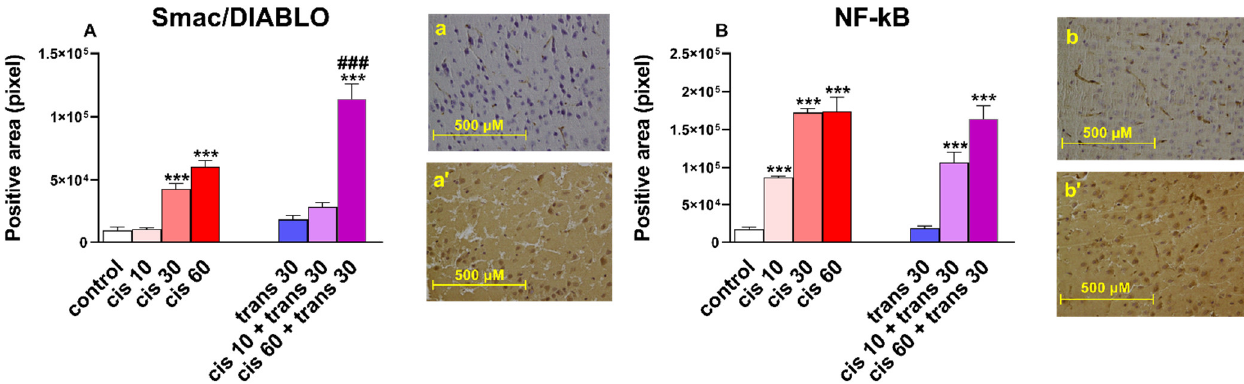
Figure 4. ( A ) Quantification and comparison of Smac/DIABLO positive areas in controls versus 4-4′-DMAR-mice ((±) cis 10, (±) cis 30, (±) cis 60, (±) trans 30, (±) trans 30 + (±) cis 10, (±) trans 30 + (±) cis 60).). Comparison of (±) cis 60 versus (±) trans 30 + (±) cis 60. Representative image (light microscopy, 40×) of Smac/DIABLO immunostaining (brown areas) in the cortex of mice receiving 4-4′-DMAR ((±) trans 30+(±) cis 60, a’) and controls (a). ( B ) Quantification and comparison of NF-κB positive areas in controls versus 4-4′-DMAR-mice ((±) cis 10, (±) cis 30, (±) cis 60, (±) trans 30, (±) trans 30 + (±) cis 10, (±) trans 30 + (±) cis 60). Representative image (light microscopy, 40x) of NF-κB immunostaining (brown areas) in the cortex of mice receiving 4-4′-DMAR ((±) cis 10, b’) and controls (b). *** p < 0.001 different from control; ### p < 0.001 different from (±) cis 60.